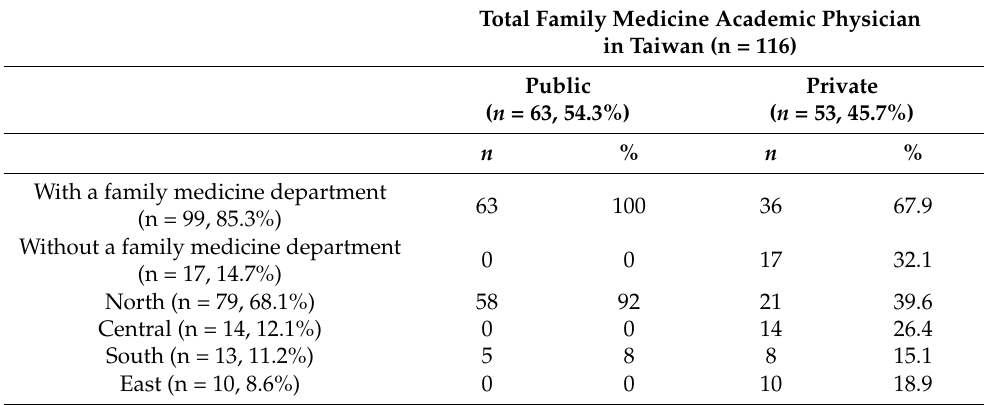
Table 2. Distribution of family medicine academic physicians of medical schools in Taiwan ( n =